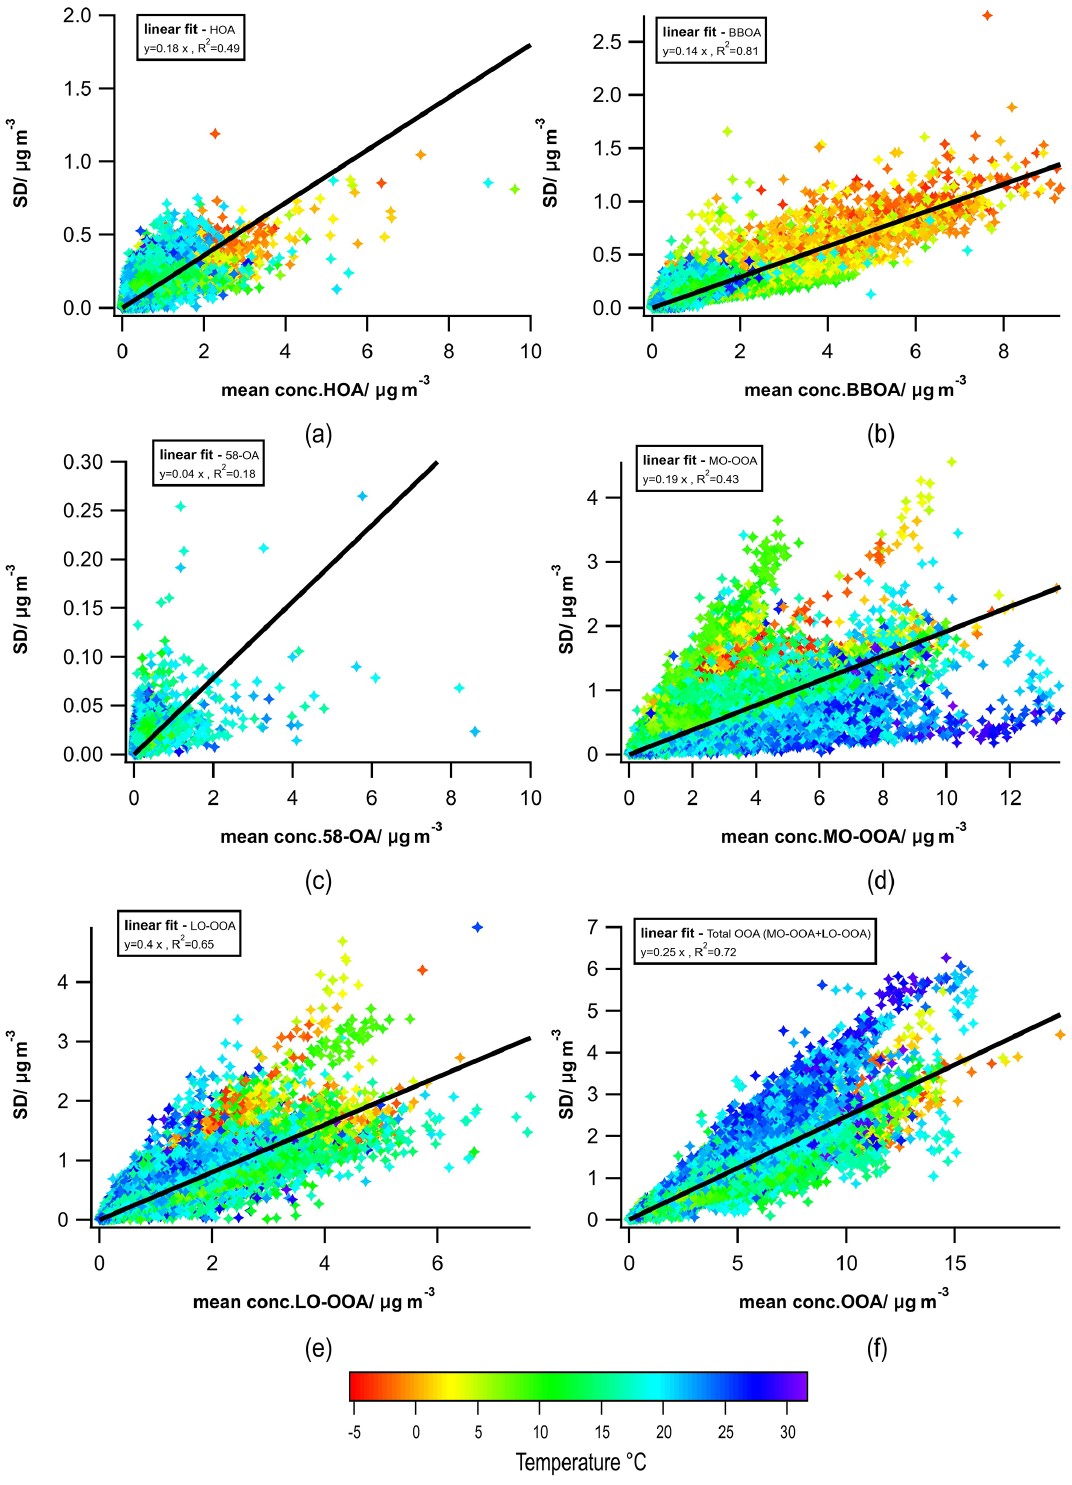
Figure 8. Absolute statistical uncertainties in PMF for HOA, BBOA, 58-OA, LO-OOA, MO-OOA, and total OOA (LO-OOA + MO-OOA) for all data. The data points are colour-coded by temperature. The PMF error (uncertainties) of selected PMF runs and rotational uncertainties are estimated using the slope of the linear regression of standard deviation ( σ ) vs. the averaged mass concentration ( µ ) for each factor.